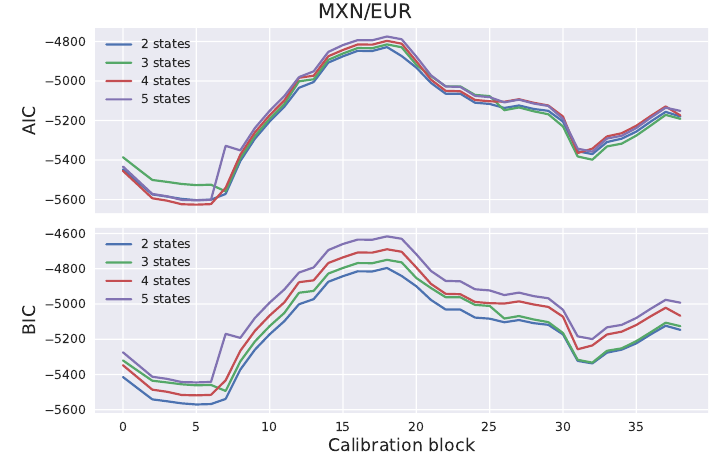
Figure 6. AIC and BIC for HMMs calibrated using MXN/EUR